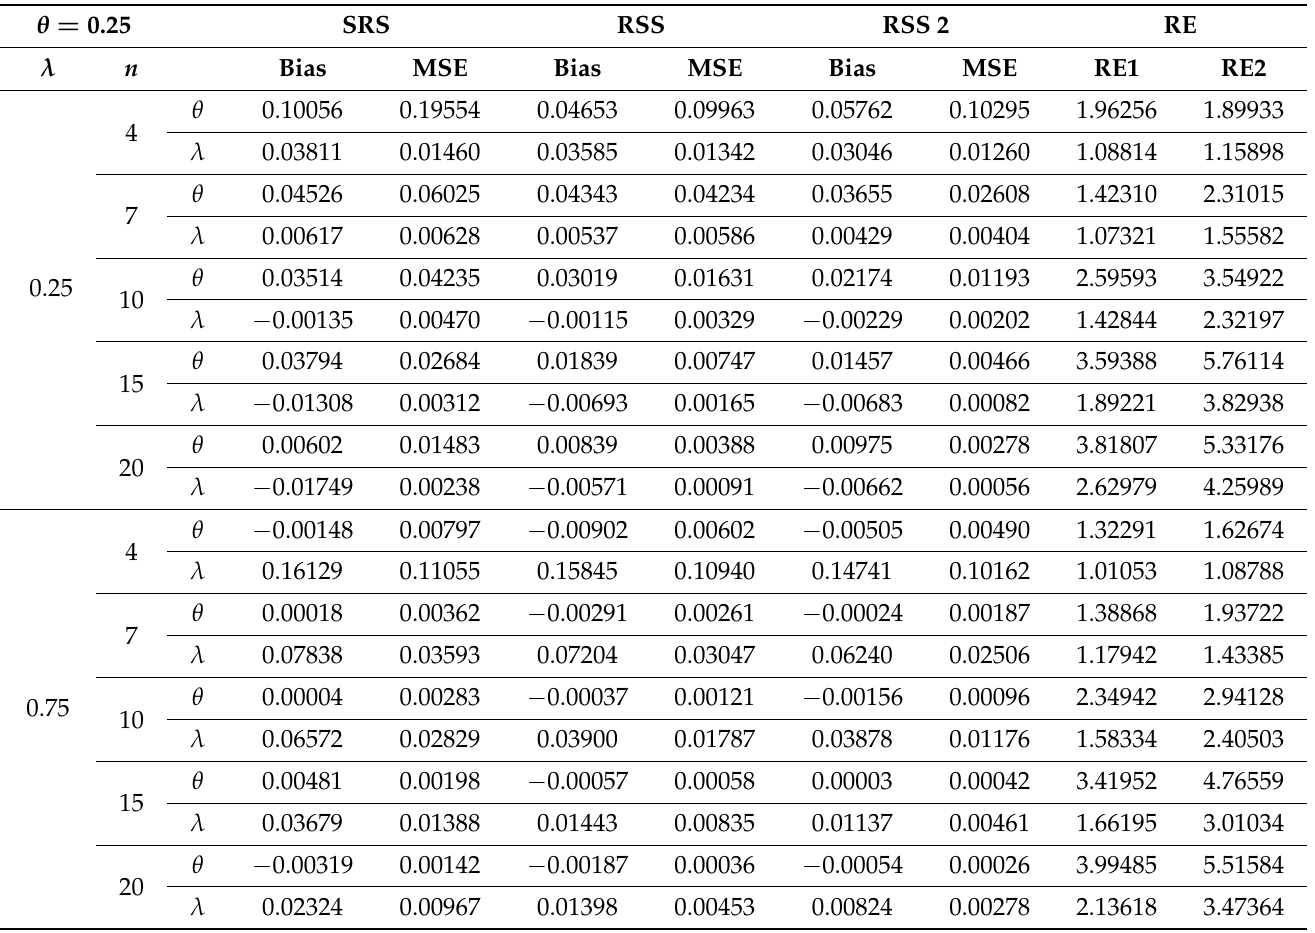
Table 3. Bias, MSE, and RE for the GB( θ , λ ) distribution under the SRS and RSS schemes when θ =